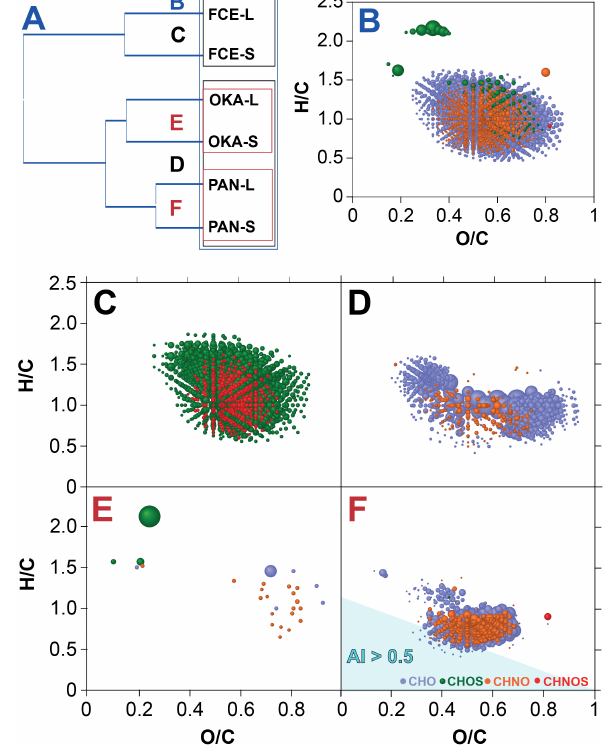
Figure 8. Comparative analysis of van Krevelen diagrams derived from negative electrospray 12T FT-ICR mass spectra of all six wetlands SPE-DOM. (a) Clustering diagram based on the similar- ity values between the spectra of six wetlands SPE-DOM using Pearson correlation coefficient; (b) molecular compositions com- mon to all six wetlands SPE-DOM, (c) unique molecular compo- sitions common in FCE samples (FCE-L and FCE-S); (d) unique molecular compositions with high abundance in both PAN samples; (e) unique molecular compositions with high abundance in both OKA samples; ( f) unique molecular compositions common in all four PAN and OKA. The aromaticity index AI (Koch and Dittmar, 2006) provided denotes single aromatic compounds for AI>0.5 (bright blue